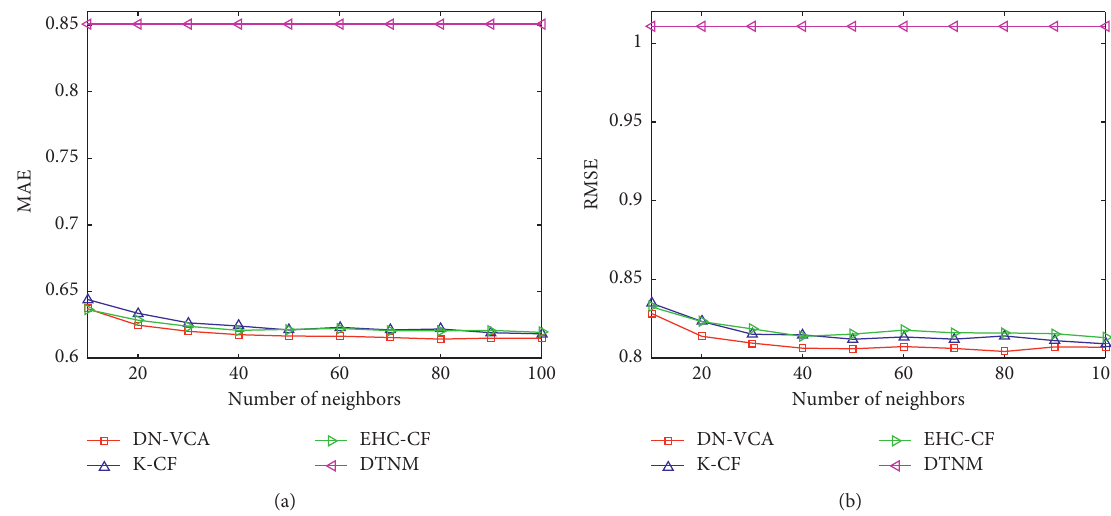
Figure 11: FilmTrust-1. (a) Comparison results of MAE of four algorithms. (b) Comparison results of RMSE of four algorithms. Table 5: Precision, recall, and F